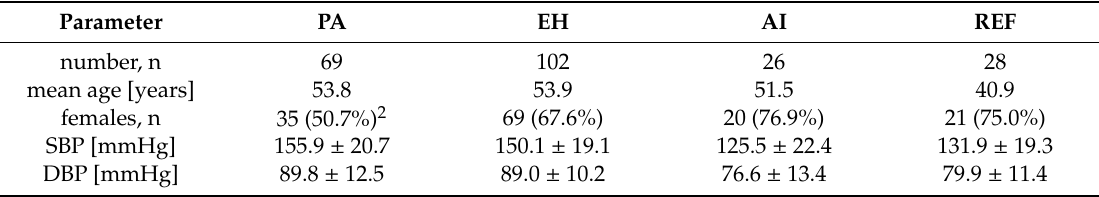
Table 1. Main patient